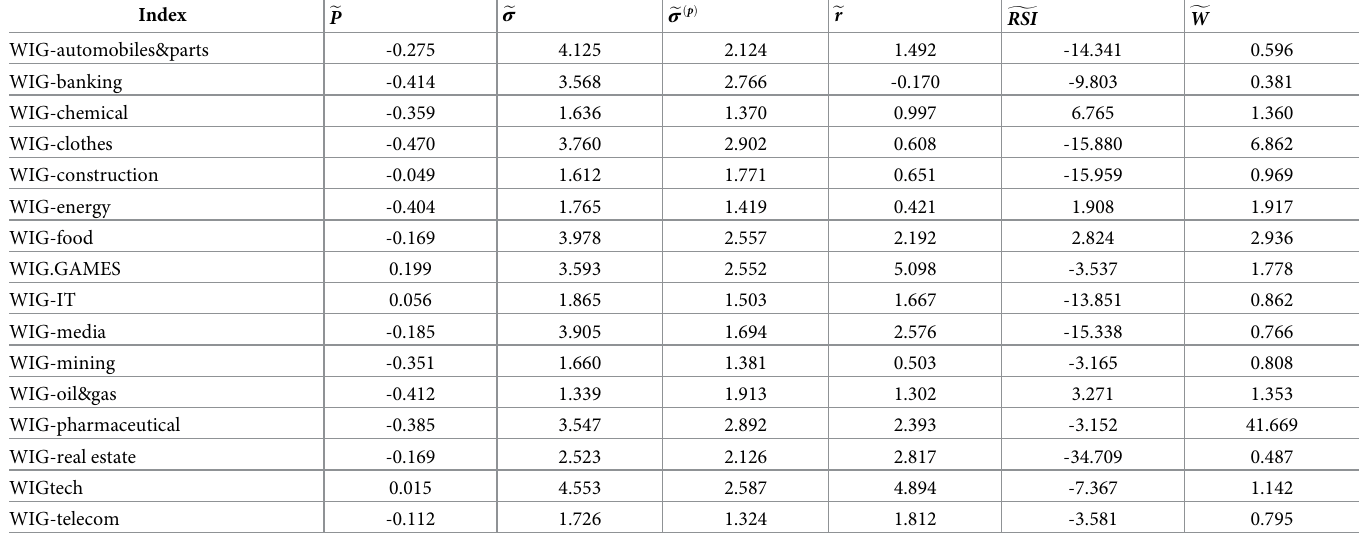
Table 4. Values of the proposed measures for evaluated sub-indices–Period_2b.